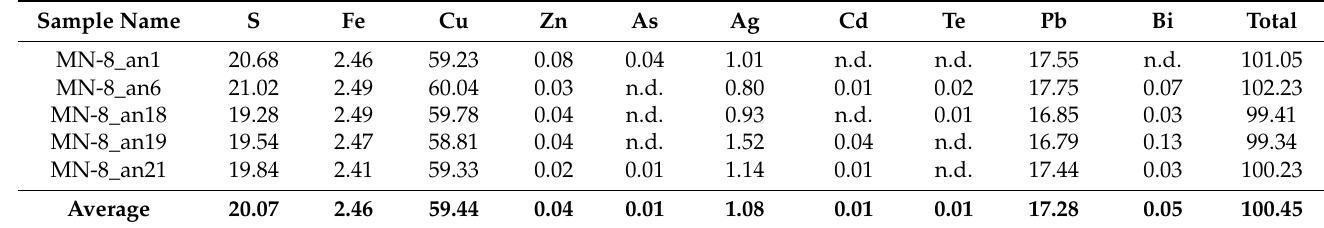
Table 3. Electron microprobe analyses for the unnamed mineral (wt.%).